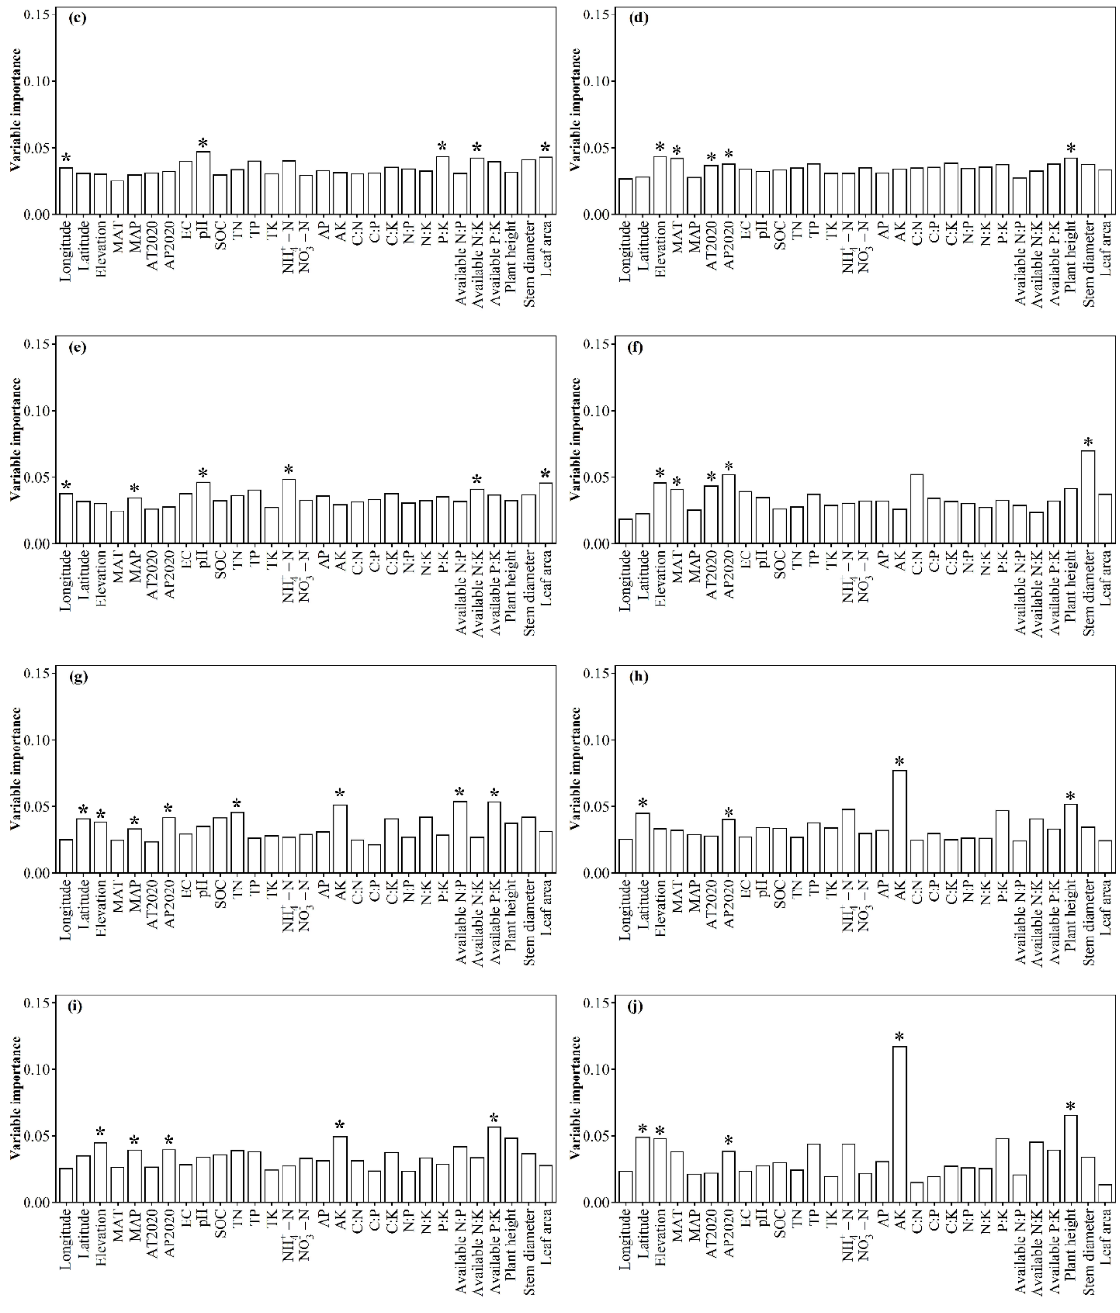
Figure 4. Relative impacts of environmental variables on ( a , b ) guild numbers, ( c , d ) Chao1 f , ( e , f ) ACE f , ( g , h ) Shannon f and ( i , j ) Simpson f for ( a , c , e , g , i ) topsoil and ( b , d , f , h , j ) subtopsoil, respectively. The * above the bar indicated this variable had a significant influence on function α -diversity of soil